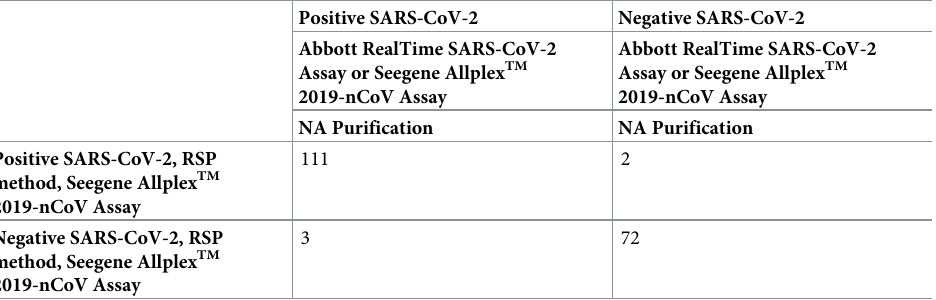
Table 2. Contingency table used for positive and negative percent agreement with NA purification-based testing